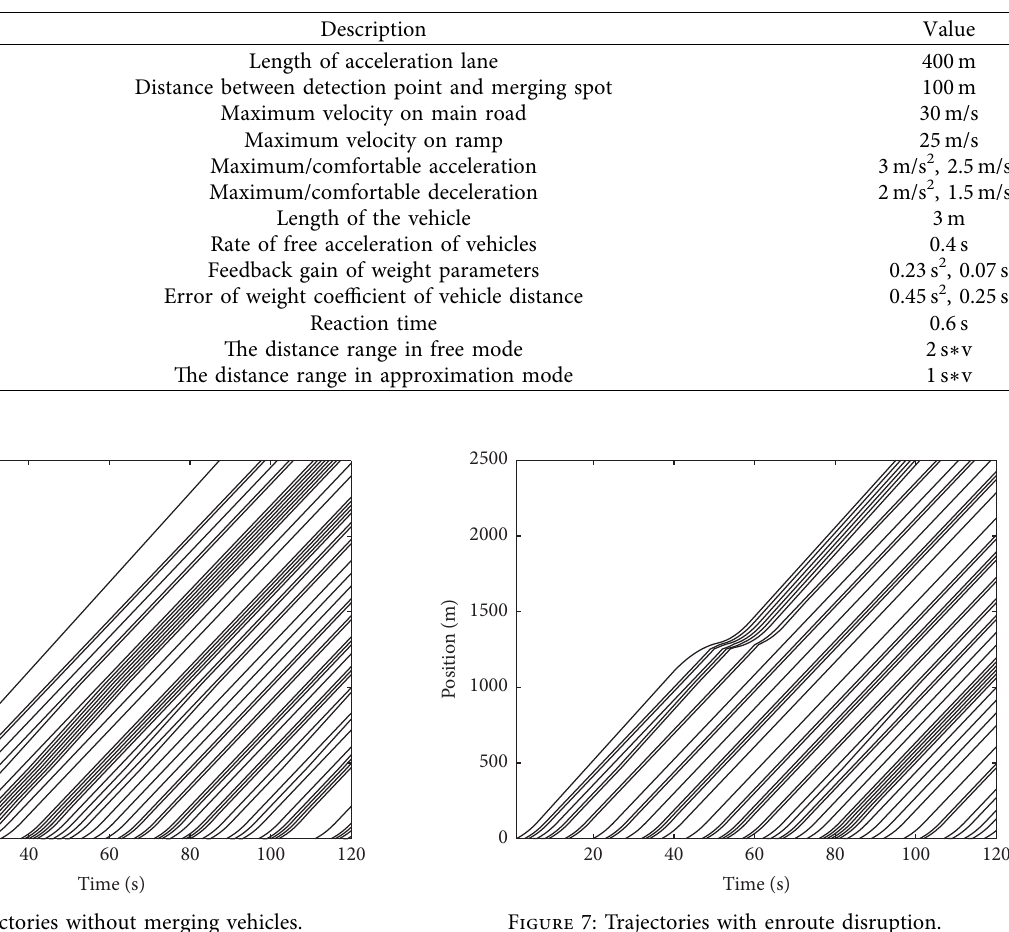
Table 1: Example parameters values.